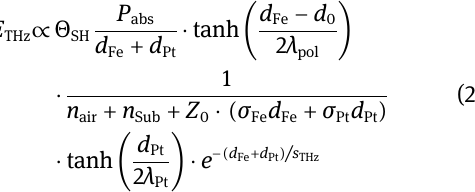
(NM) layer. Pt has so far the highest efficiency for THz emission. Reprinted by permission from Springer Nature, Nature Photonics,